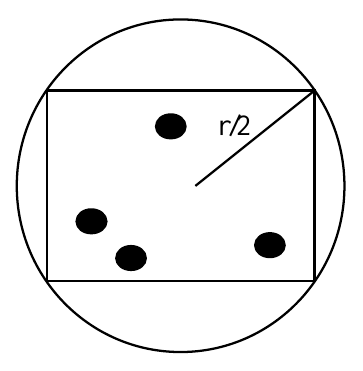
Figure 2. The inscribed square of the circle.